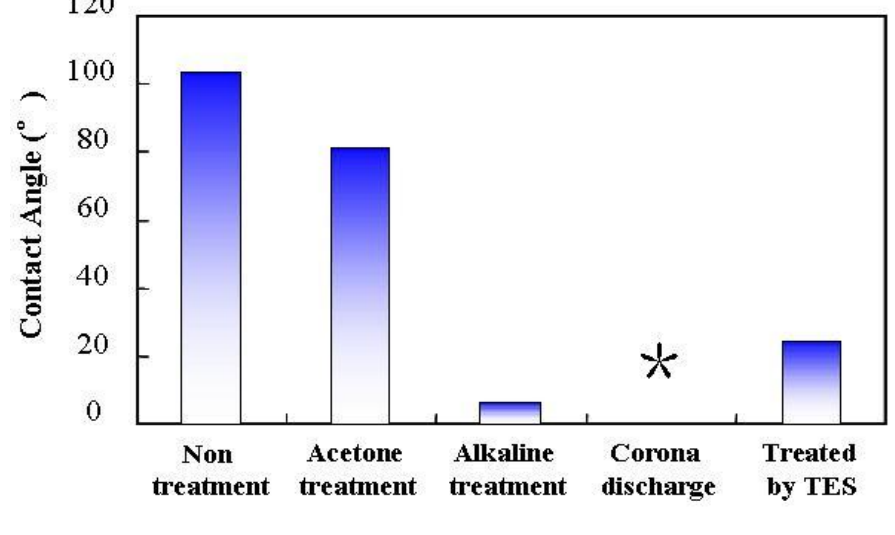
Figure 1. Effect of different pretreatment and modification of aluminum surface on the contact